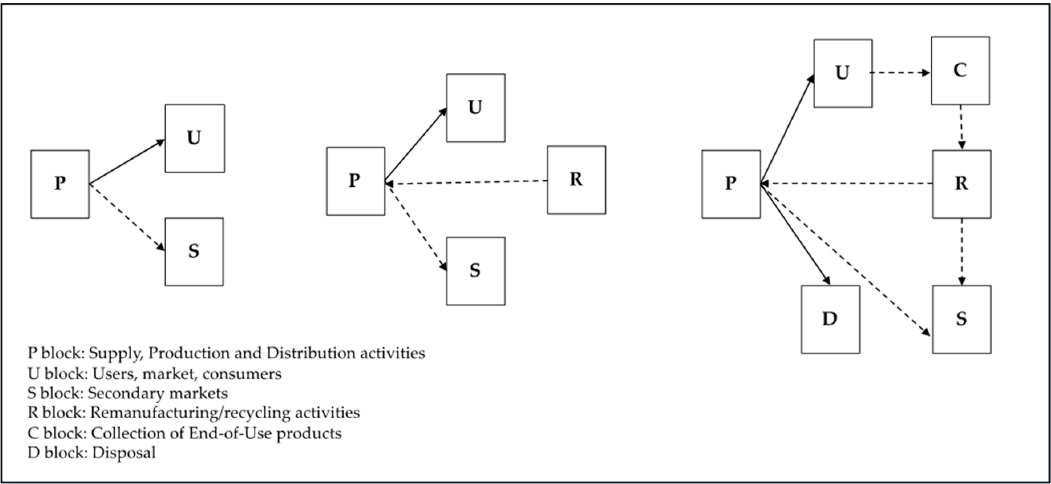
Figure 3. Macrostructure for three potential scenarios.